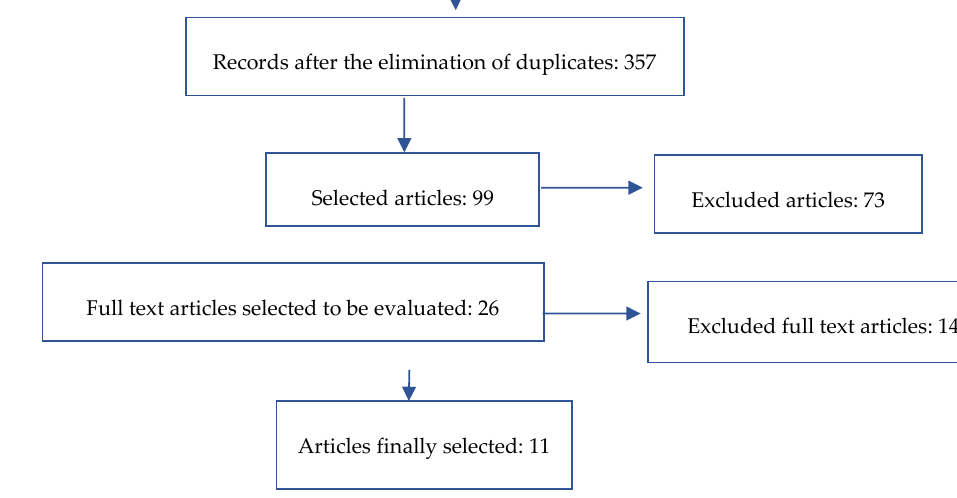
Figure 1. Literature review flowchart.